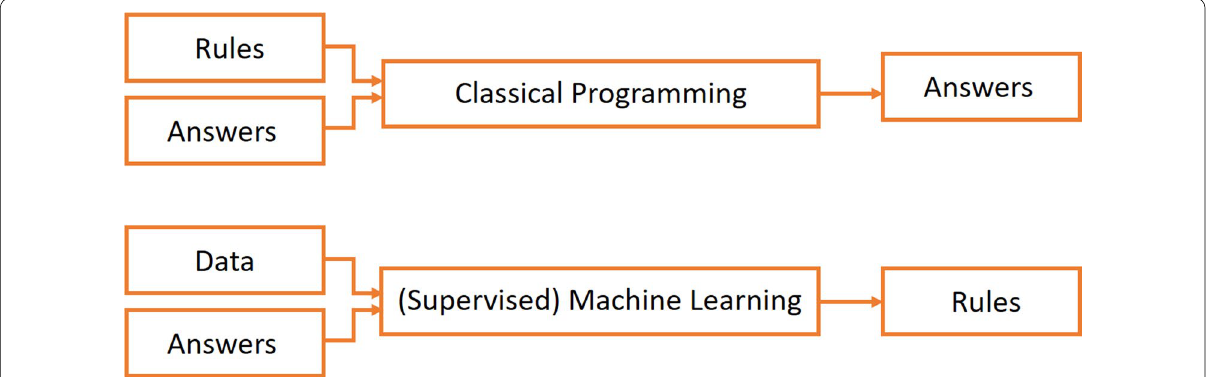
Fig. 1 Classical programming vs supervised learning